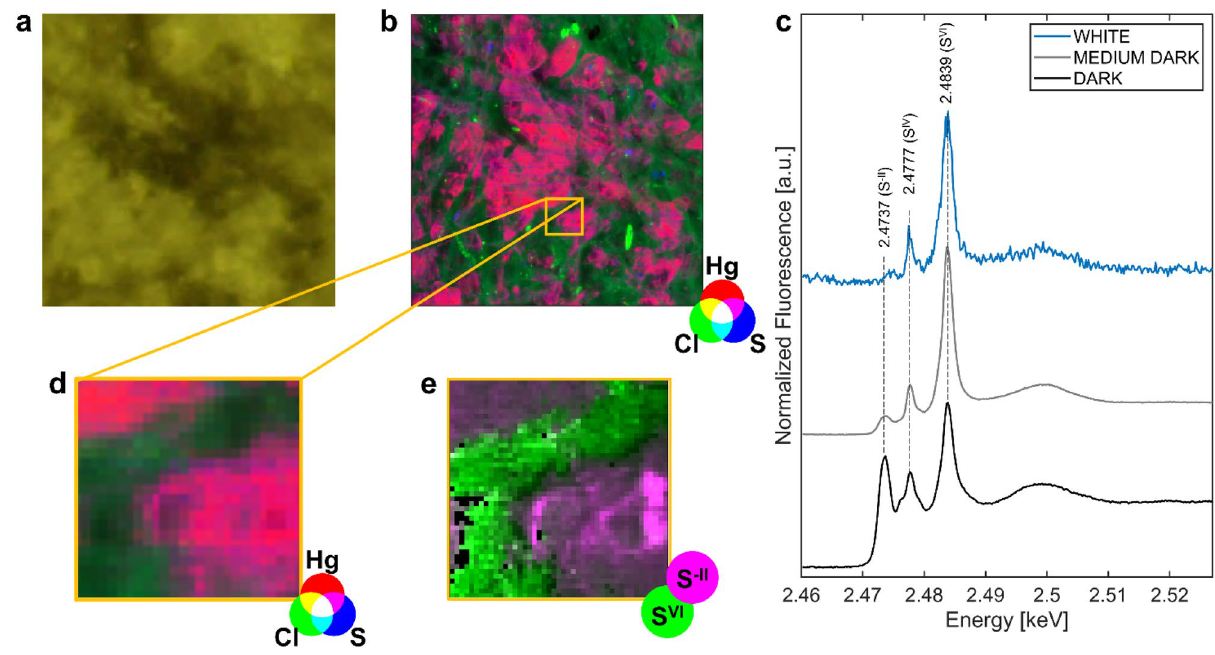
Figure 7. ( a ) Visible light image of the black stains region analyzed from the dark region. ( b ) RGB composite of SR µXRF maps of Hg (red), Cl (green) and S (blue) [step size (h × v), 4 × 4 μm; map size (h × v), 800 × 800 μm; exp. time, 100 ms/pixel; energy: 2.825 keV]. The magenta color indicates the region where mercury and sulfur signals overlap, following the shape of the black stain. ( c ) Macro-XANES spectra recorded at S K-edge (average of 45 spectra) of white , medium‑dark and dark regions. Peak at 2.4737 keV corresponds to the sulfides (S -II ), peak at 2.4777 keV to the sulfites (S IV ) and peak at 2.4839 keV to the sulfates (S VI ). It is worth noting that the intensity of the white region (blue line), before normalization, is almost zero, meaning that S is less concentrated in the white sample. ( d ) Detail of RGB composite of SR µXRF maps of Hg (red), Cl (green) and S (blue). ( e ) Selected AOI for hyperspectral 2D µXRF maps at S K-edge. The RGB composite image obtained by selecting ROIs in the hyperspectral dataset shows the distribution of sulfides (S -II ) and sulfates (S VI )